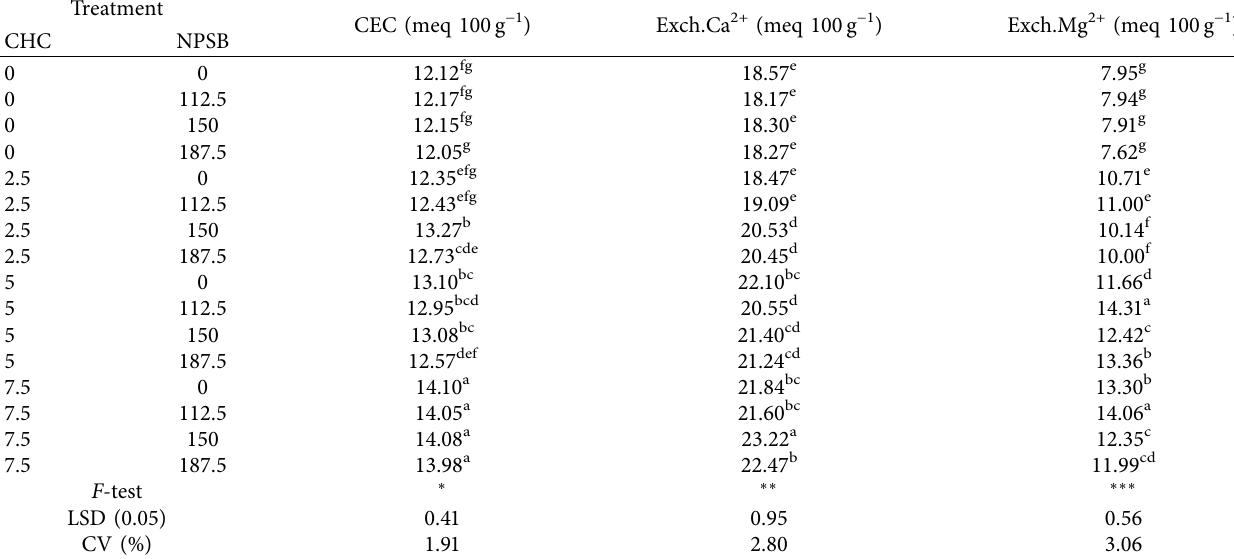
Table 5: Interaction effect of CHC and NPSB fertilizer on CEC and exchangeable bases of soils of potato field.